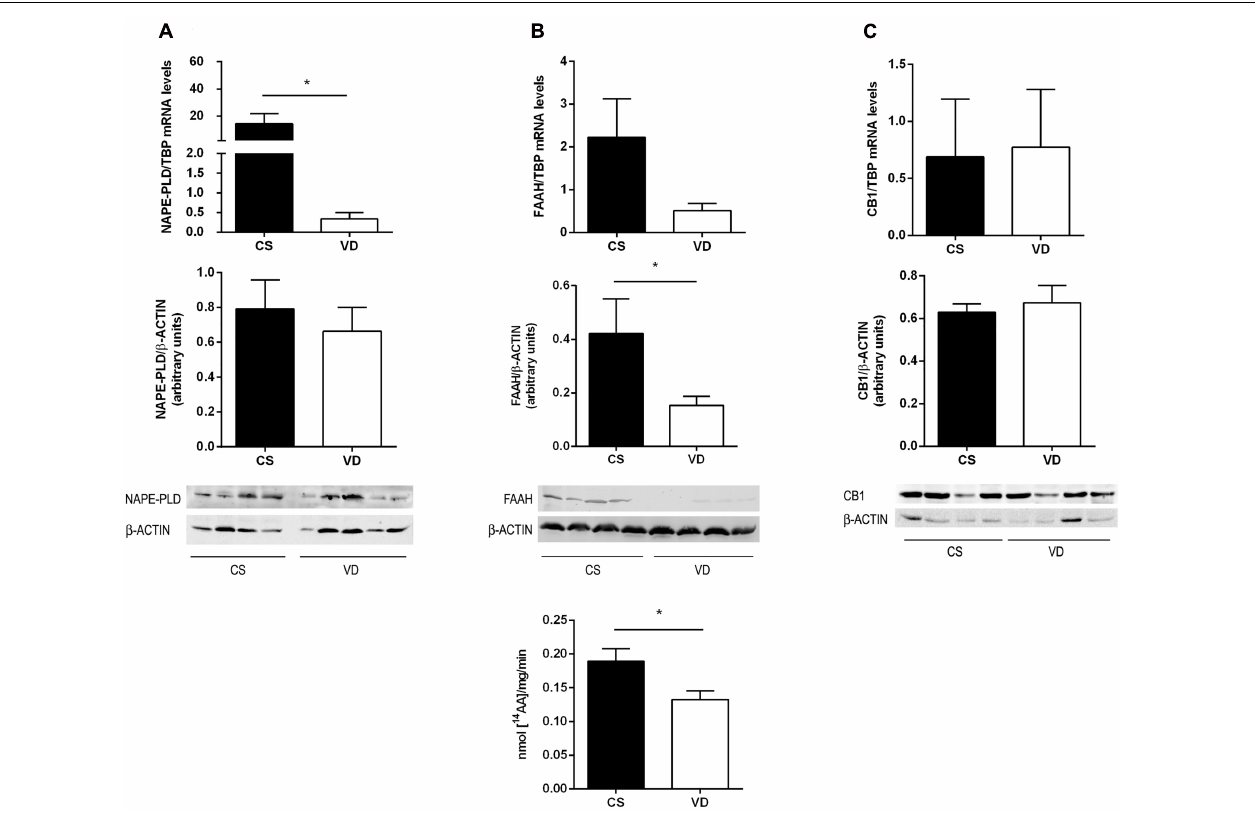
FIGURE 3 | Expression of endocannabinoid system in term placenta. (A) NAPE-PLD mRNA levels and protein content, (B) FAAH mRNA levels, protein content and enzymatic activity, and (C) CB1 mRNA levels and protein content, measured in CS and VD placentas. Representative immunoblots of protein content are shown in the lower panel (* P < 0.05, n =